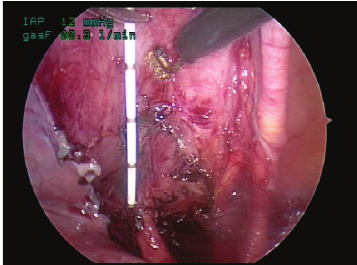
Figure 4: The tunnel should be oriented vertically and its length can be measured with a piece of ureteral catheter acting as a